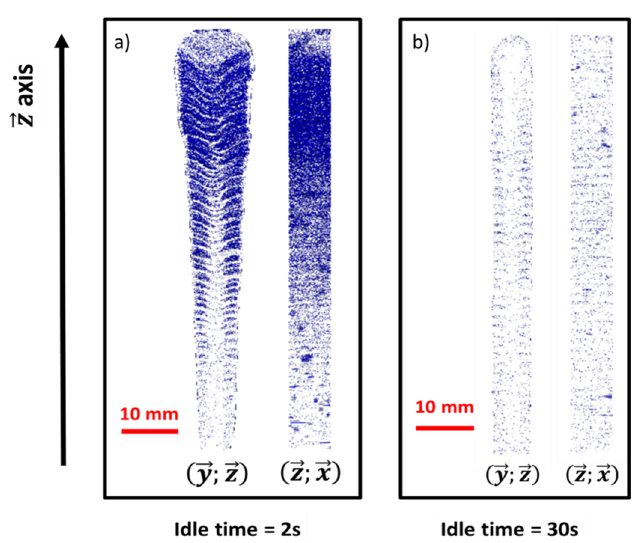
Fig. 9. Pores spatial distribution of both strategies (represented in blue): (a) idle time= 2s, (b) idle time =30 s.